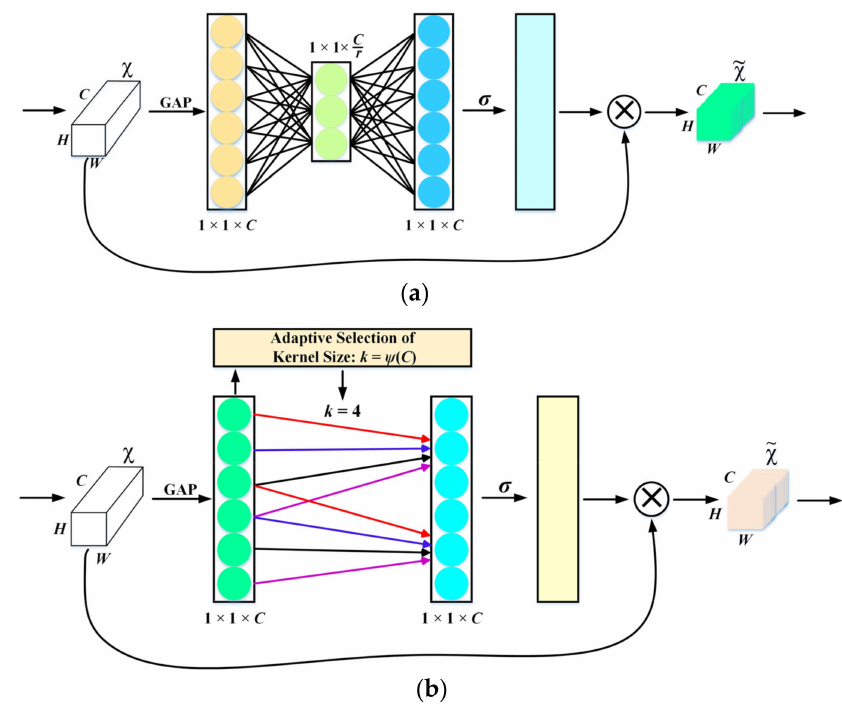
Figure 2. The structure diagrams of SE and ECA: ( a ) SE module ( b ) ECA module. In Figure 2, χ ∈ R W × H × C is the output of the convolution module. W , H , and C are the width, height, and channel dimension of feature maps, respectively. The kernel size k of 1D convolution represents the coverage of cross-channel interaction, which indicates how many neighboring channels are involved in the attention prediction of a channel. The kernel size k is proportional to the channel dimension C and can be determined adaptively by a nonlinear mapping of channel dimensions. r is the down-scaling rate, and σ is the sigmoid function, ⊗ represents the element-wise